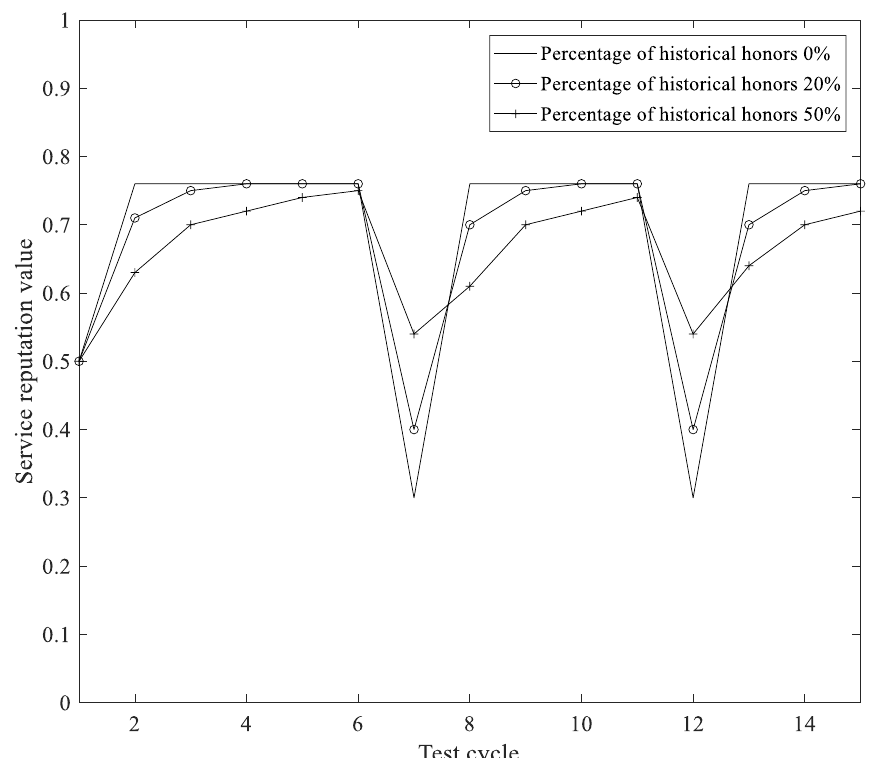
Fig. 13 Impact of historical reputation value on service reputation